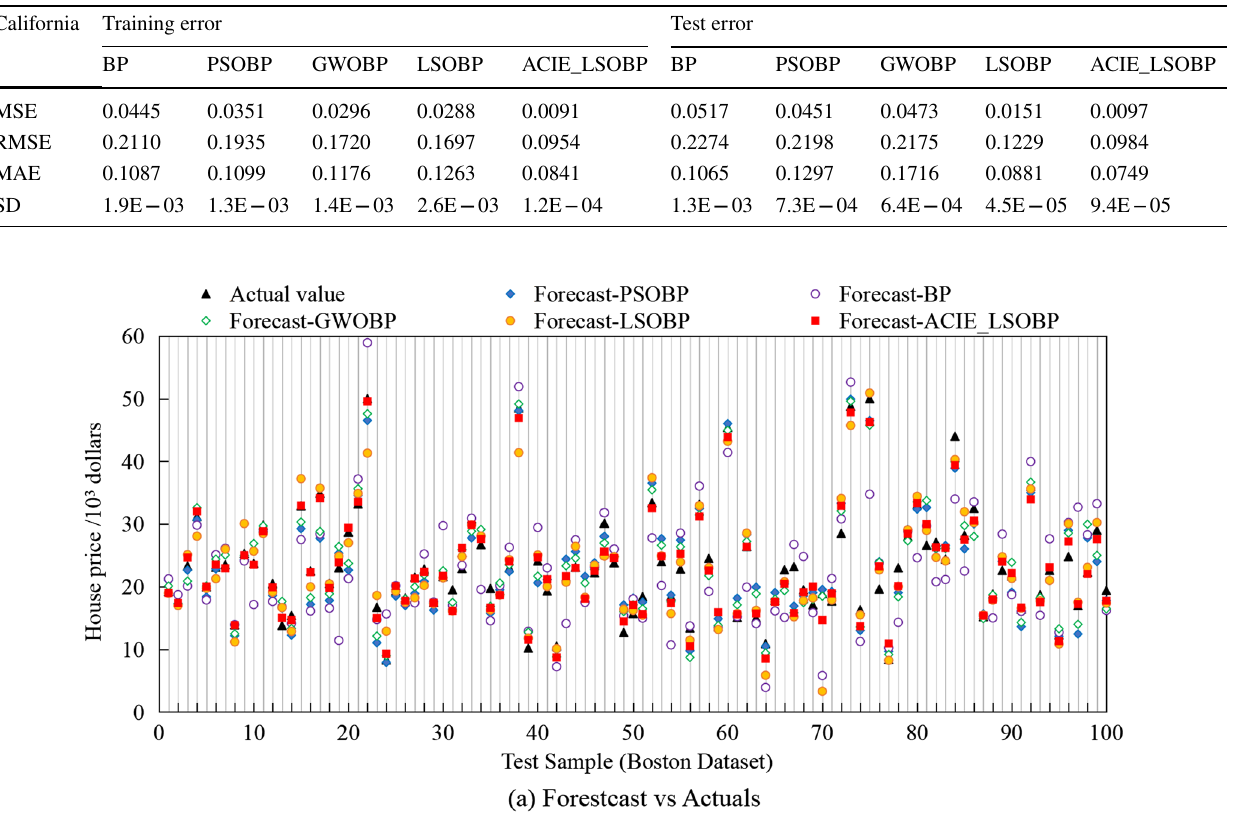
Table 9 Final training error and deviation value of each method on the California house price dataset